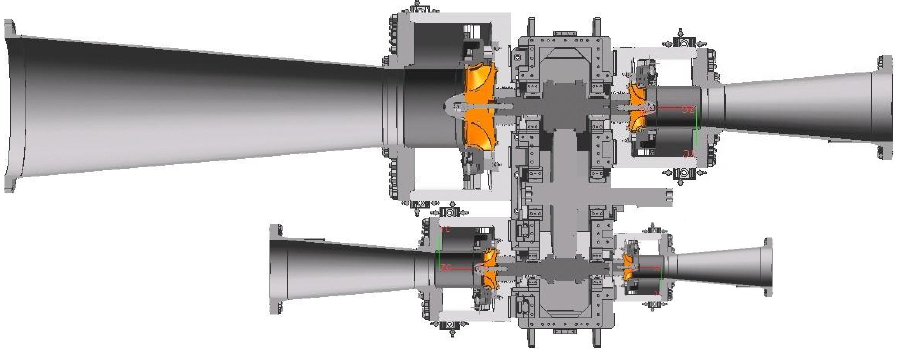
Figure 5. Integrally-Geared